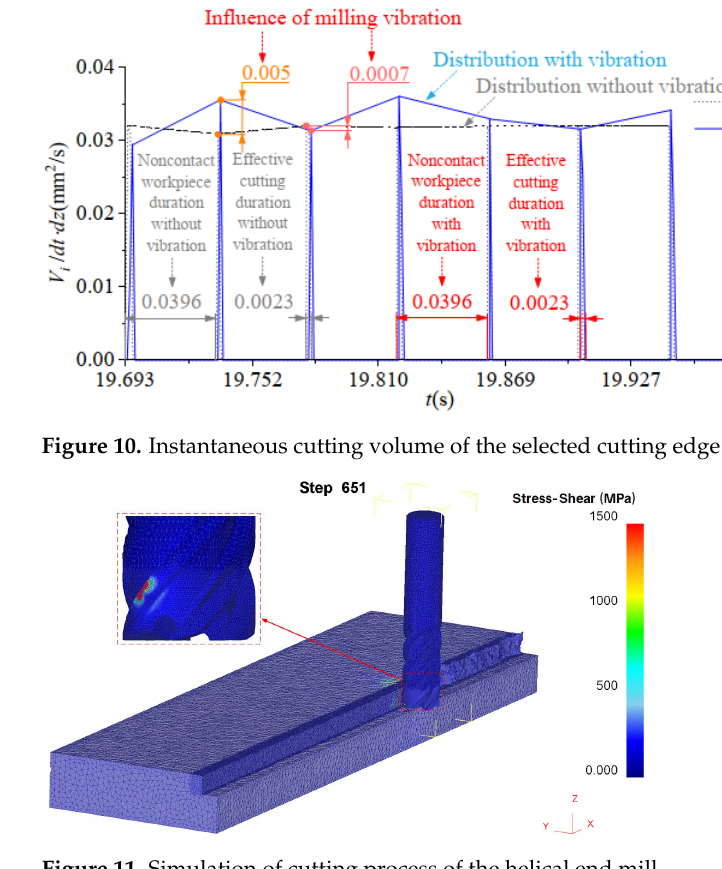
Figure 11. Simulation of cutting process of the helical end mill. Table 2. Parameters of J-C constitutive of Ti-6Al-4V titanium alloy.